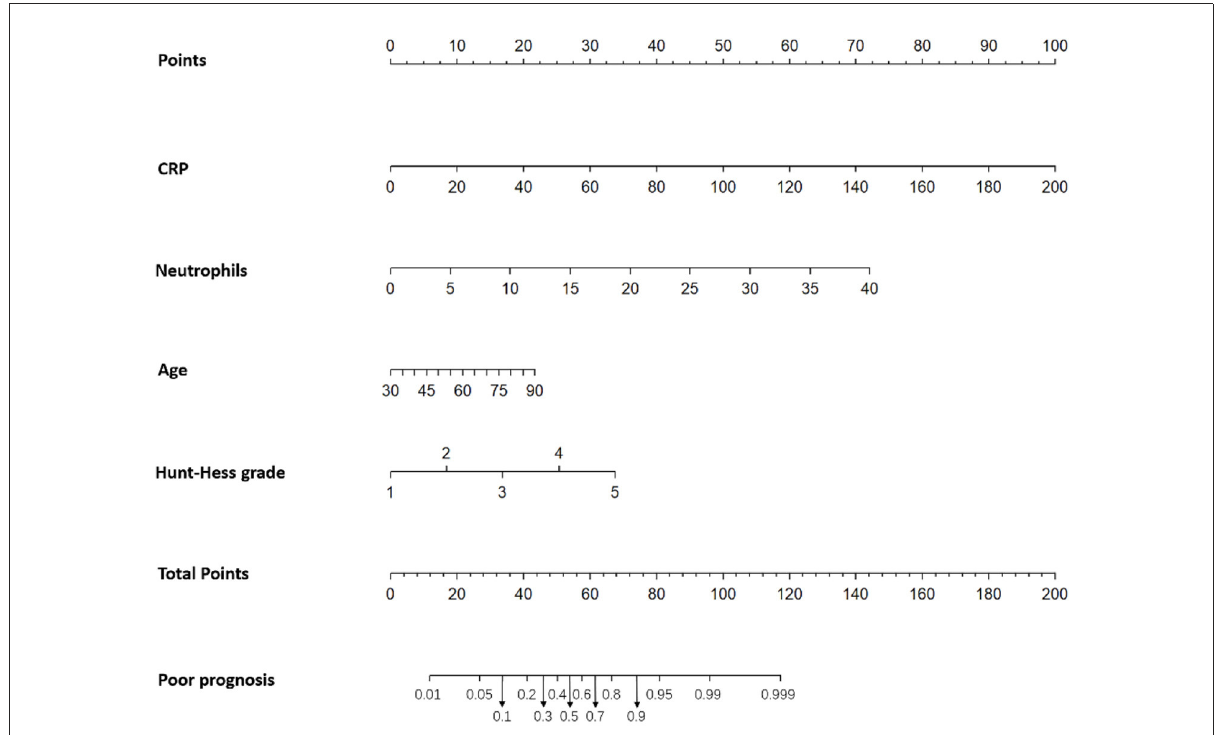
FIGURE3 Nomogram (Based on good prognosis group, poor prognosis group).